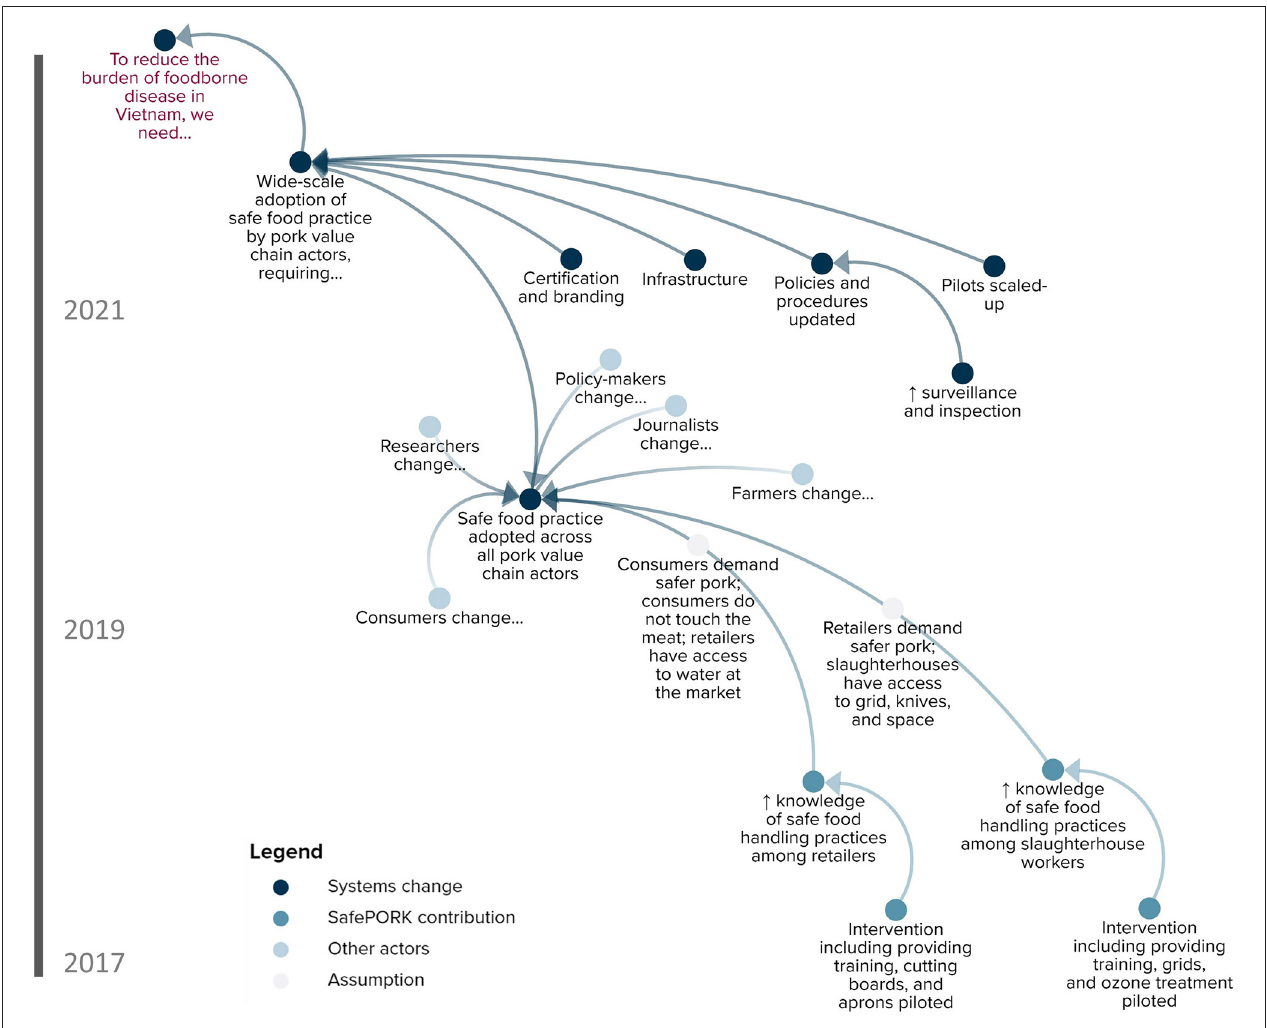
FIGURE 3 | SafePORK theory of